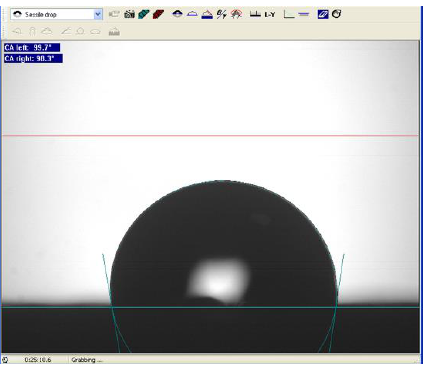
Fig. 3. Contact angle